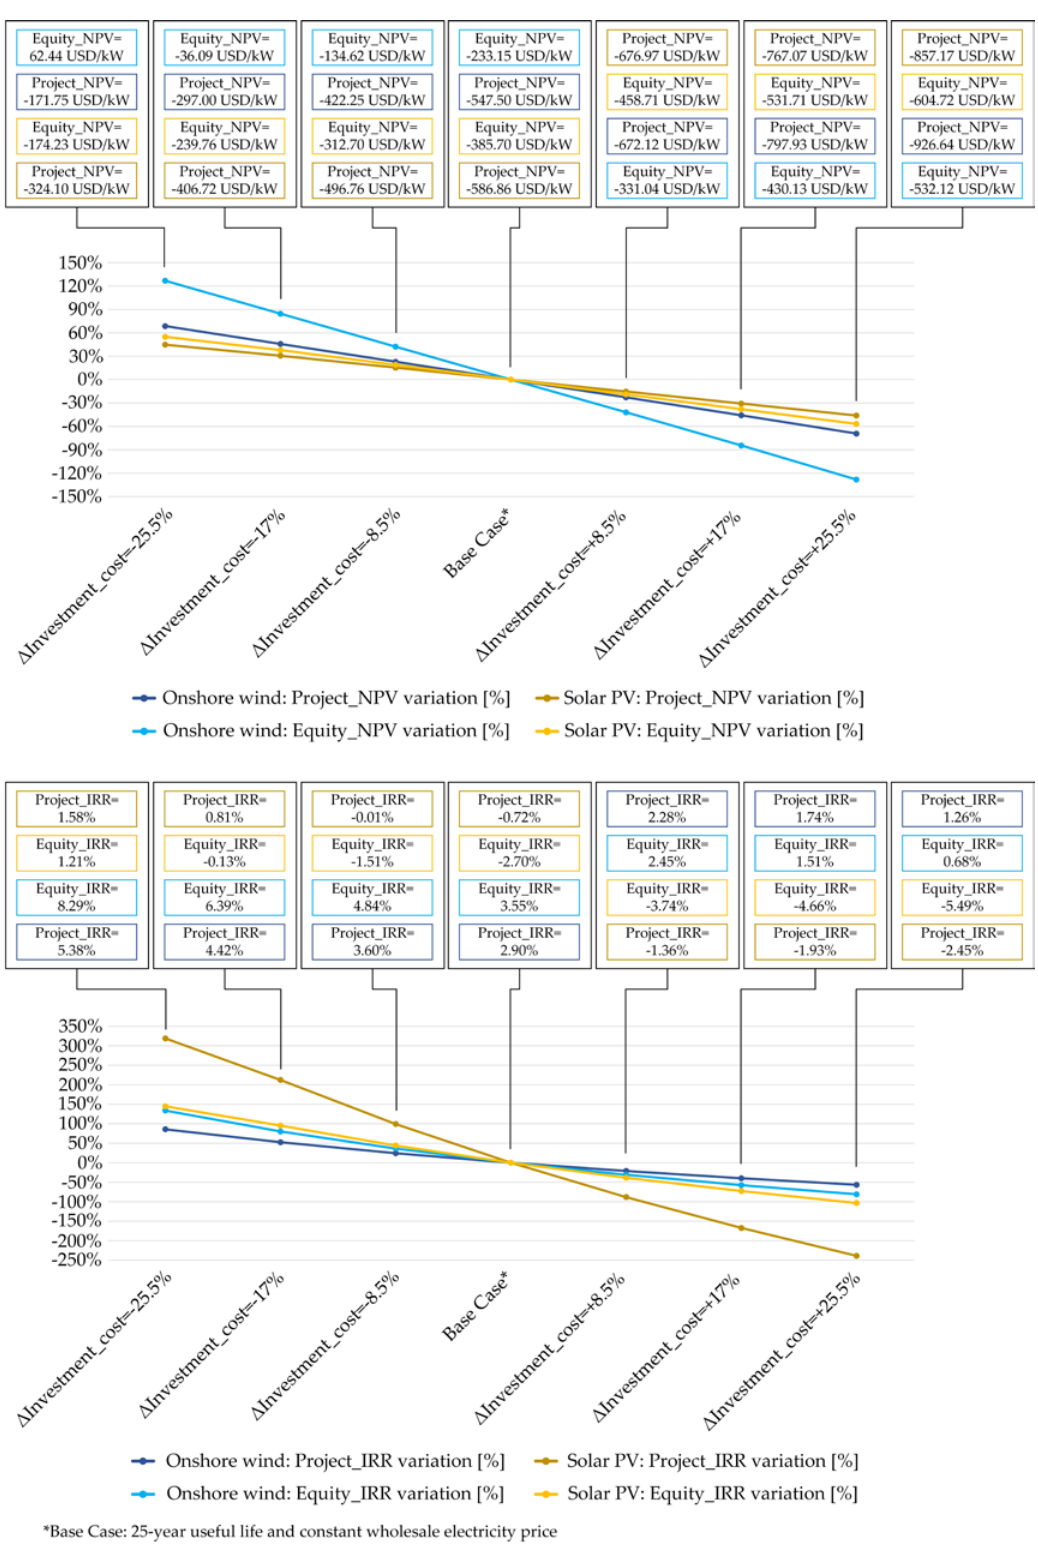
Figure 6. Project and equity NPV percentage variation (upper subplot) and project and equity IRR percentage variation (lower subplot) with investment cost percentage variation for the Danish case. Source: self ‐elaboration.